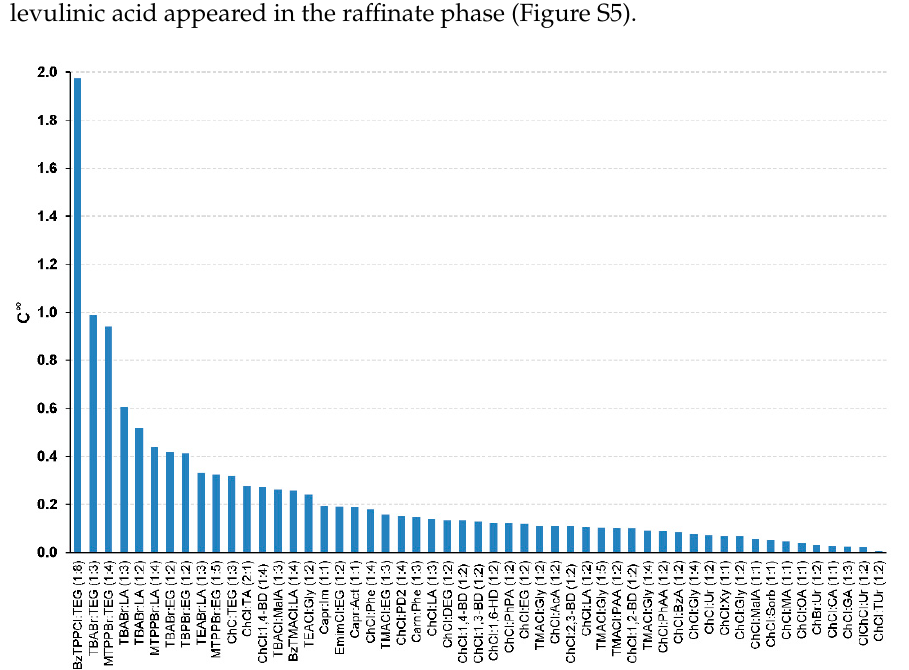
Figure 1. Capacity of the selected DESs at infinite dilution.